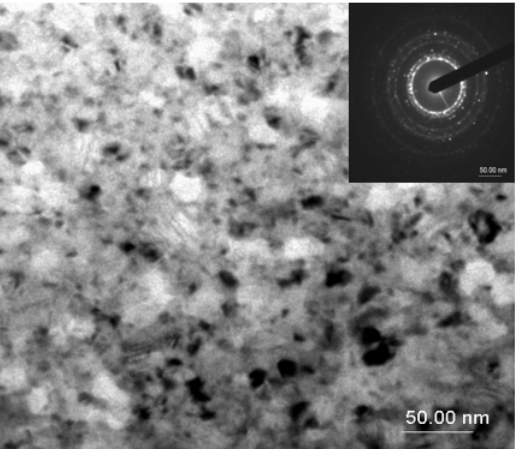
Nanomaterials 2022 , 12 , 4122 Figure 4. TEM image and corresponding EDP for the sample annealed at 700 °C. Figure 4. TEM image and corresponding EDP for the sample annealed at 700 °C. Figure 4. TEM image and corresponding EDP for the sample annealed at 700 ◦ C.